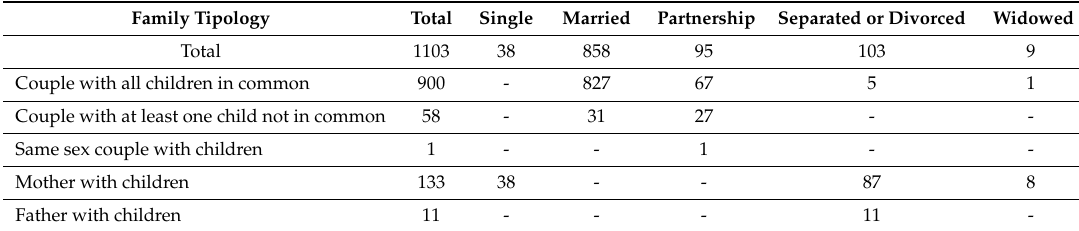
Table 2. Profile of the sample interviewed: family typology and parents’ marital